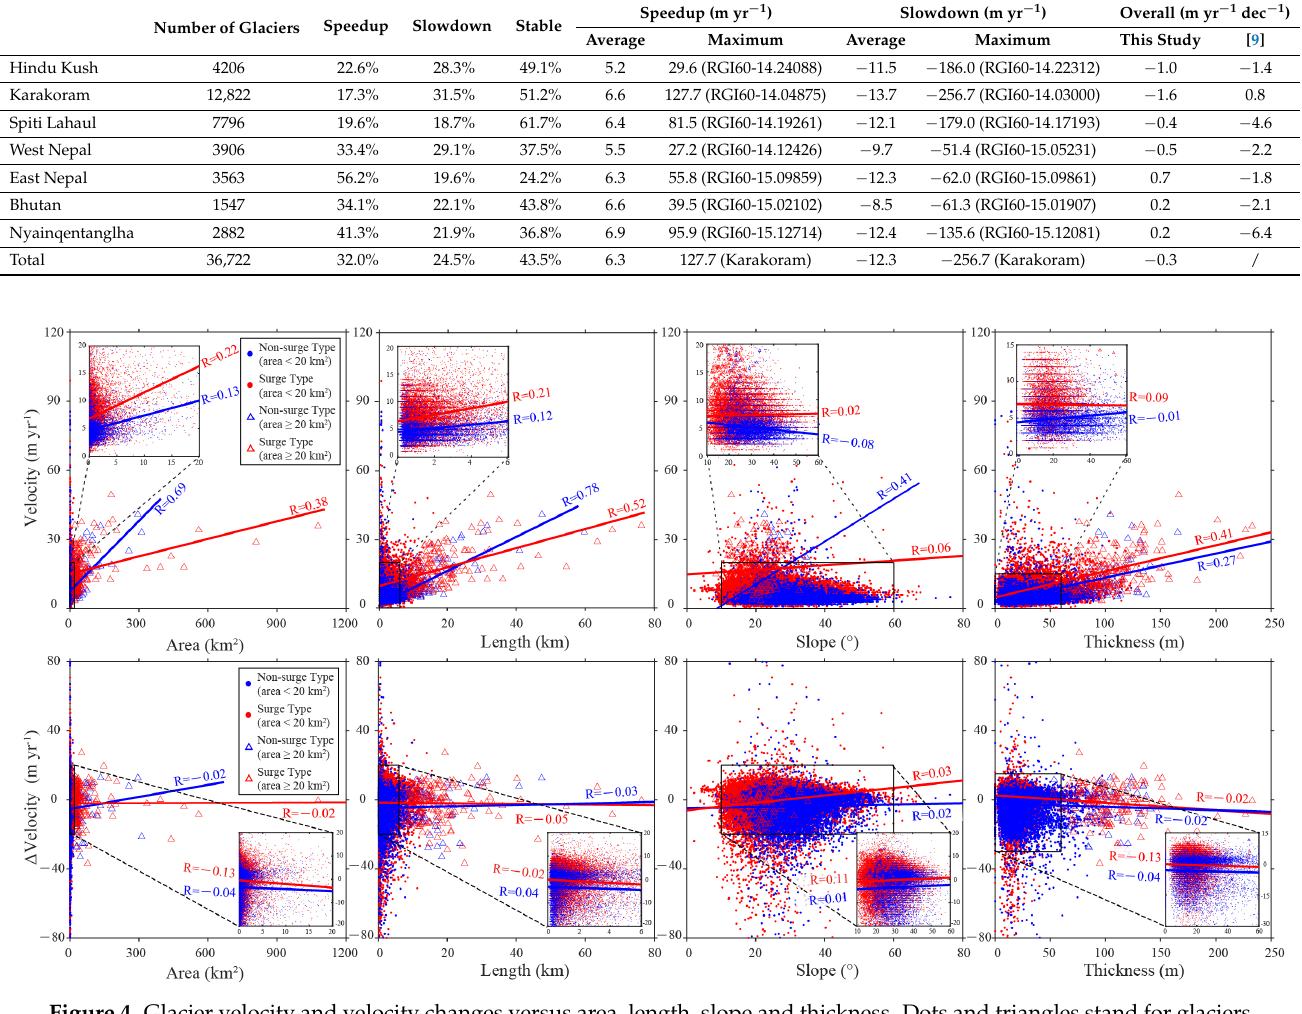
Figure 4. Glacier velocity and velocity changes versus area, length, slope and thickness. Dots and triangles stand for glaciers with an area of smaller than 20 km 2 and over 20 km 2 , respectively. Non-surge- and surge-type glaciers are separated by blue and red. Lines show the linear regression analysis of the corresponding group of